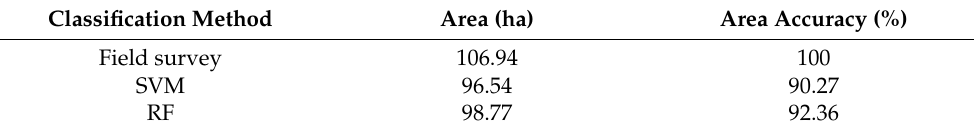
Table 7. Corn cultivation area and accuracy according to classification